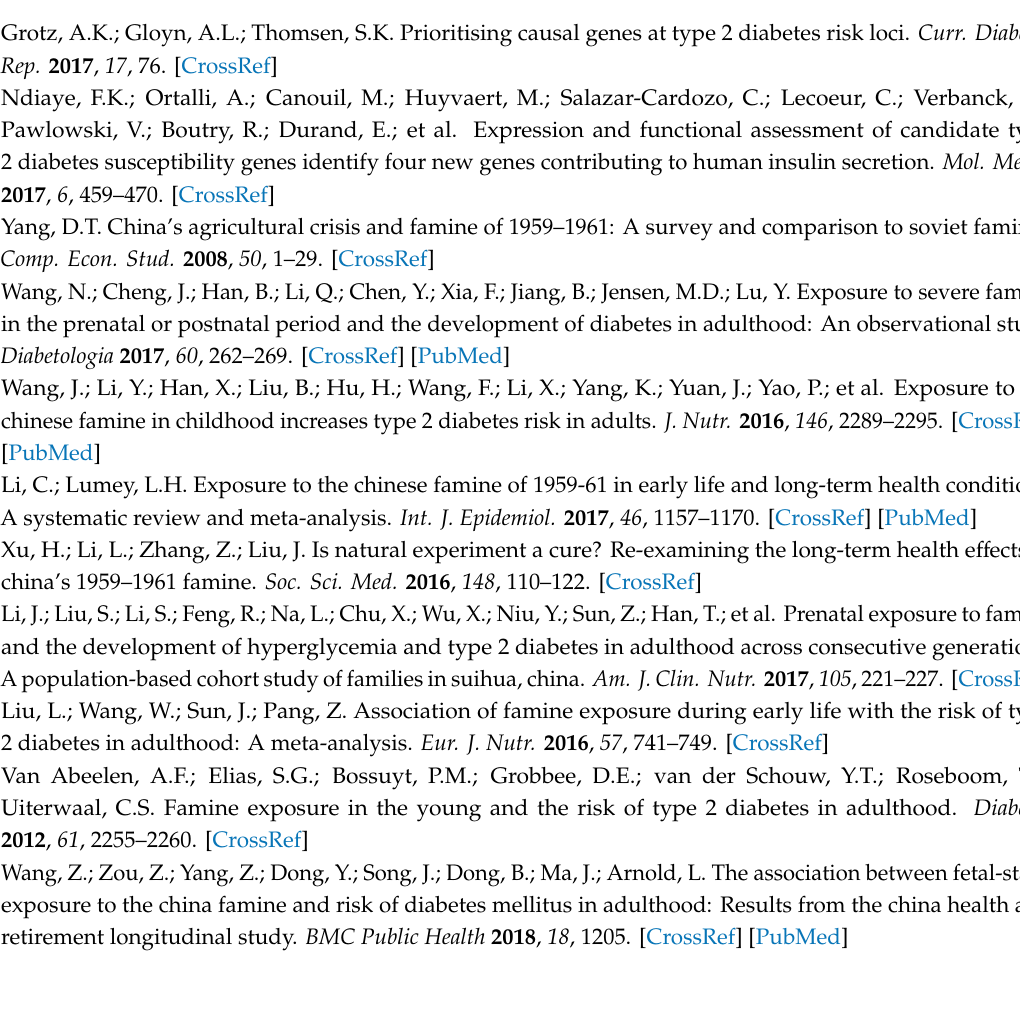
Table S1: Hardy–Weinberg equilibrium